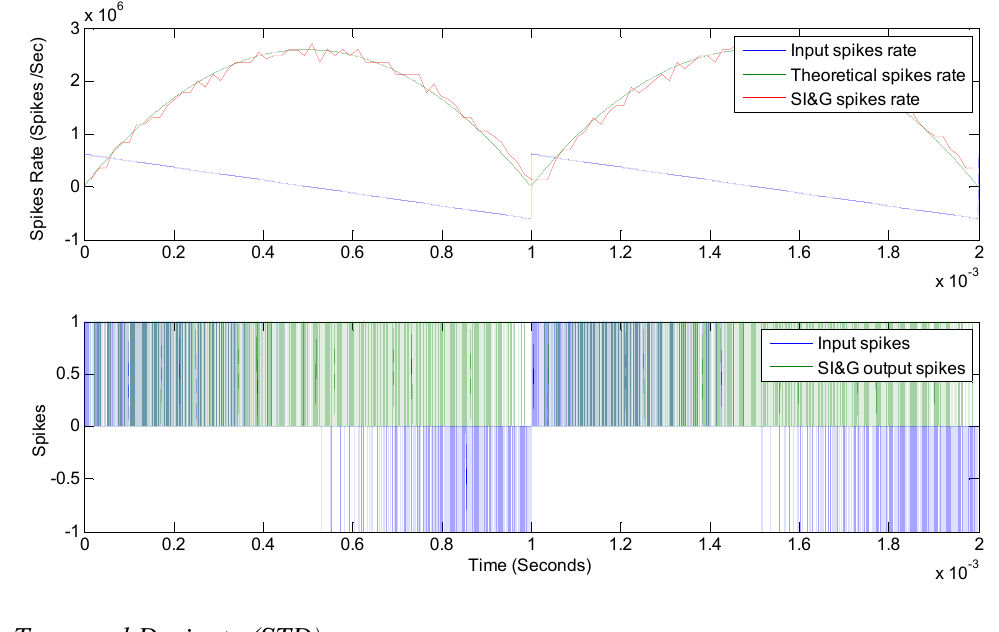
Figure 11. Spikes Integrate & Generate response.